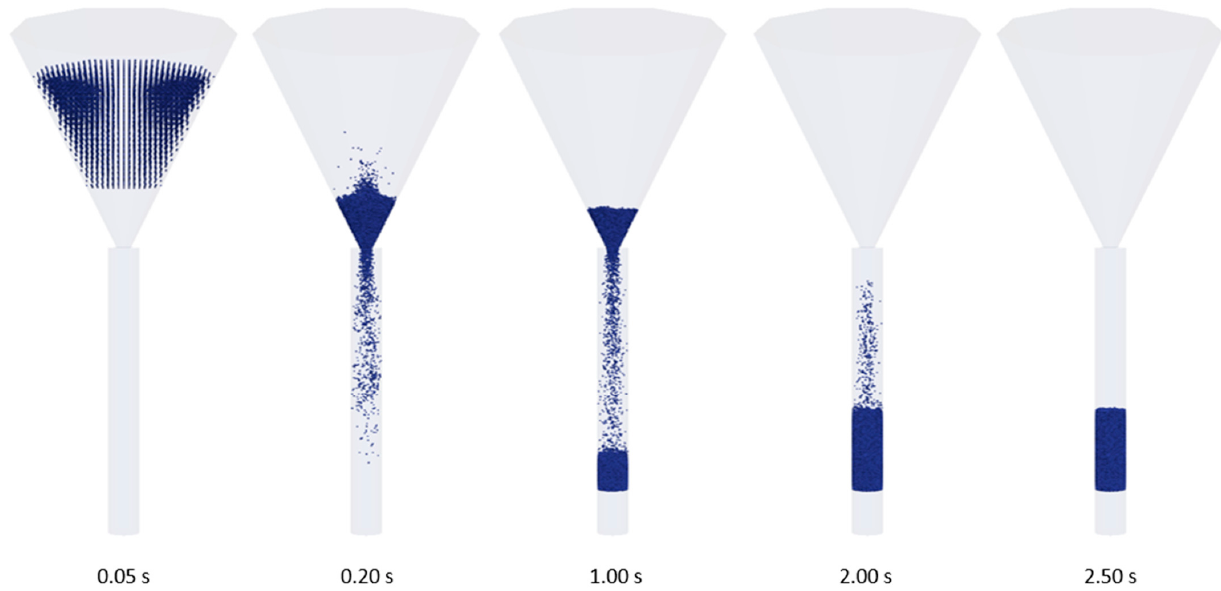
Figure 2. Different phases of particle settling at the beginning of the simulations (28 mm column, 7.4 cm bed height).